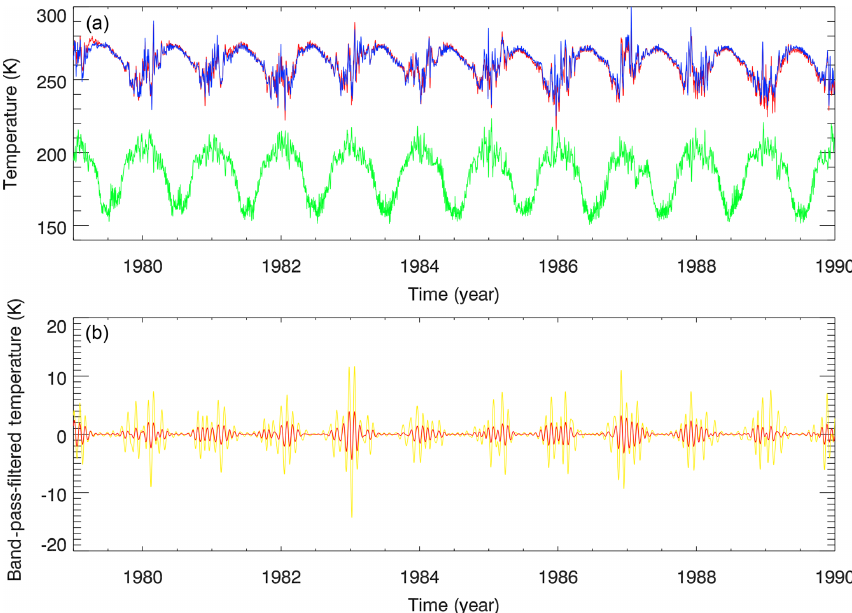
Figure 11. (a) Temporal evolution of ERA-Interim (red) and CMAM (blue) temperatures at about 1hPa (about 48km) and CMAM temper- ature (green) at 0.01hPa (about 80km) averaged over the Eifel mountain region from 1 January 1979 to 31 December 1989. (b) Band-pass- filtered CMAM temperatures for a 24–31-day filter (red) and a 20–40-day filter (yellow) at